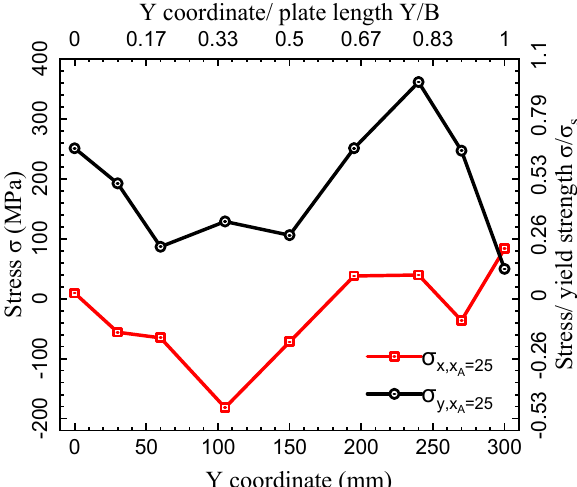
𝐿 . . (cid:3051) (cid:3250) (cid:2880)(cid:2870)(cid:2873) (cid:3250) (cid:2880)(cid:2870)(cid:2873)